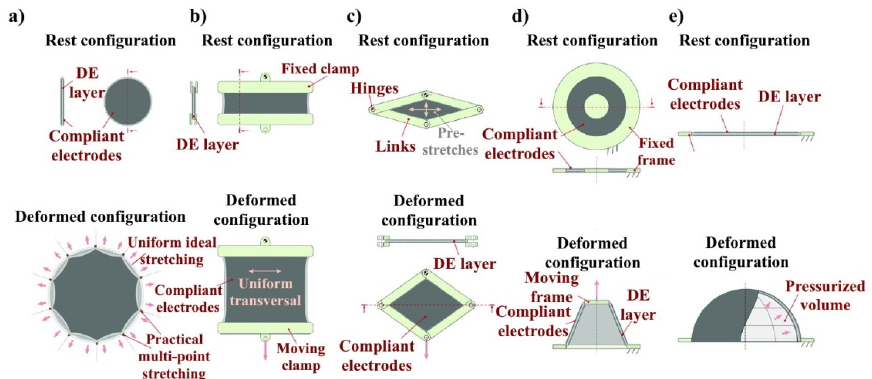
Figure 5. Some topologies of DEG. ( a ) Equibiaxial DEG (ideal uniformly stretched generator, and practical multipoint stretching embodiment); ( b ) pure shear (namely, strip ‐ biaxial) DEG; ( c ) diamond DEG; ( d ) cone DEG; and ( e ) circular diaphragm DEG [21].